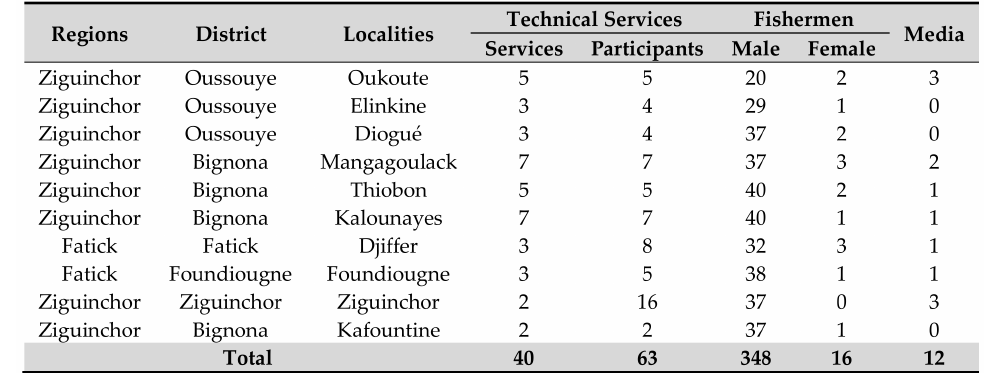
Figure 5. Pictorial representation of the trained districts in 2017 (source: from authors). Table 3. Distribution of trainings’ Beneficiaries (source: from